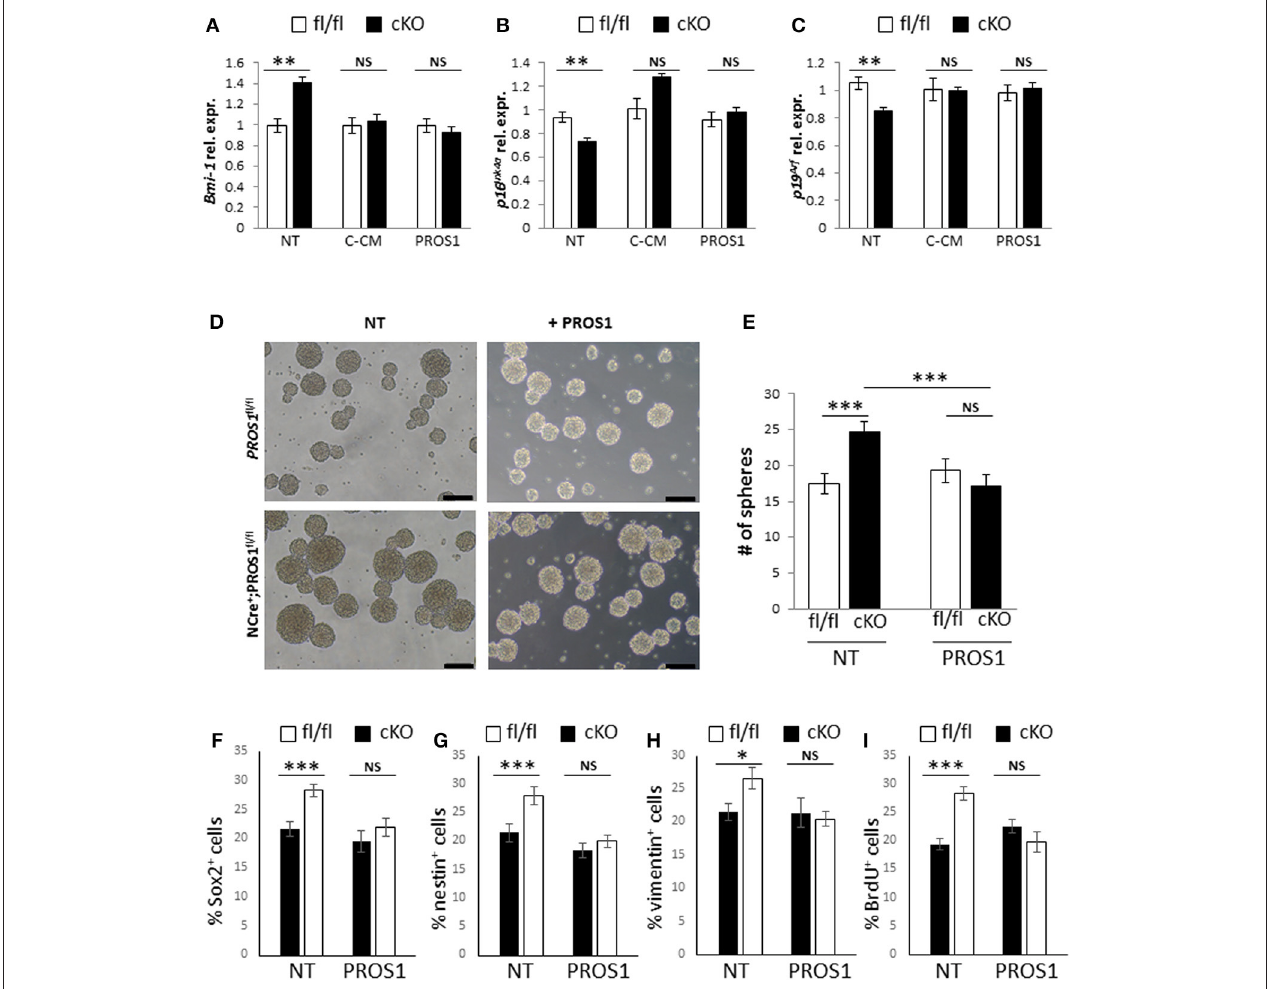
FIGURE 6 | Both Bmi-1 pathway genes and self-renewal are rescued following addition of exogenous PROS1. (A–C) Purified PROS1 rescues Bmi-1 pathway gene expression. RT-qPCR relative expression levels of Bmi-1 (A) p16 Ink4a (B) and p19 Arf (C) in neurospheres derived from Pros1 -cKO NSPCs that were grown either in their own conditioned medium (NT), following exchange of CM from control cells (C-CM), or grown in medium supplemented with purified PROS1 (35 nmol/Lit). ** P < 0.01; NS, no statistical significance. Mean values ± SEM were derived from 4 independent experiments. Statistics are derived from measuring at least 100 neurospheres in each experiment. (D–I) Neural stem cell self-renewal in Pros1 -cKO NSPCs is rescued by purified PROS1. Phase contrast (D) and quantification (E) of self-renewal following addition or not of purified PROS1 (35 nmol/Lit) from NSPCs derived from control (fl/fl, white bars) or Pros1 -cKO mice (cKO, black bars). *** P < 0.001; NS, no statistical significance. Mean values ± SEM were derived from four independent experiments. Statistics are derived from measuring at least 200 neurospheres per condition in each experiment. Scale bars: 50 µ M. Decreased self-renewal by exogenous PROS1 is also evident by the numbers of